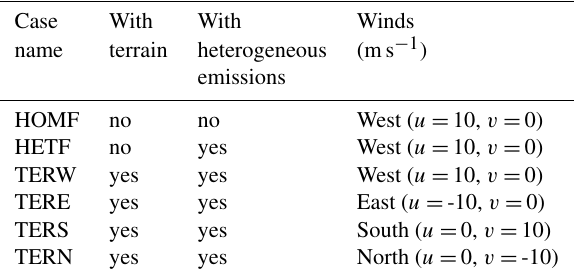
Table 2. List of the numerical experiments.